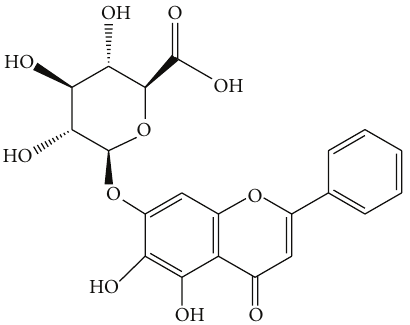
Figure 1: Chemical structure of